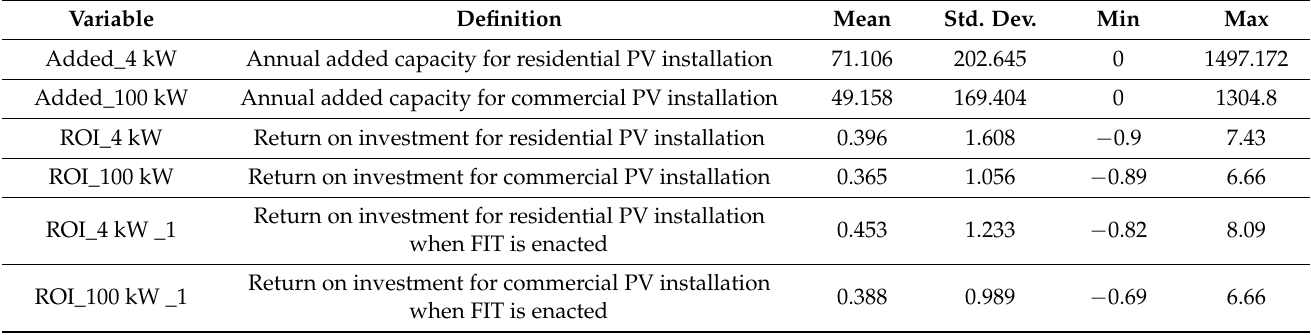
Table A1. Definition of variables and summary